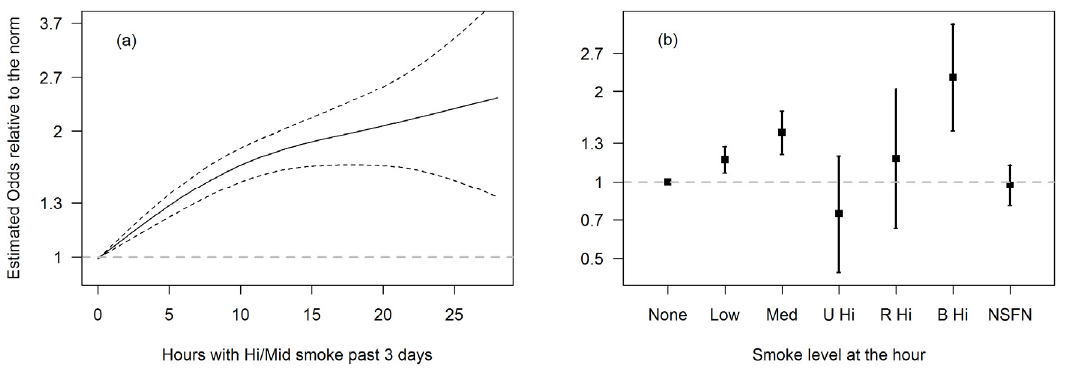
Figure 3. Estimates odds (and approximate 95% CL) of ozone exceeding the norm, relative to the odds of exceedance when there is no fire impact (horizontal line at one). The “no smoke but fire nearby” (NSFN) category in the right panel includes cases with observed fire within 10 km of site but no observed smoke above the site. ( a ) for number of hours with high or medium level smoke in the past 3 days, ( b ) for smoke level at that hour (None, Low, Medium Urban High, Rural High, Baseline High, and NSFS).